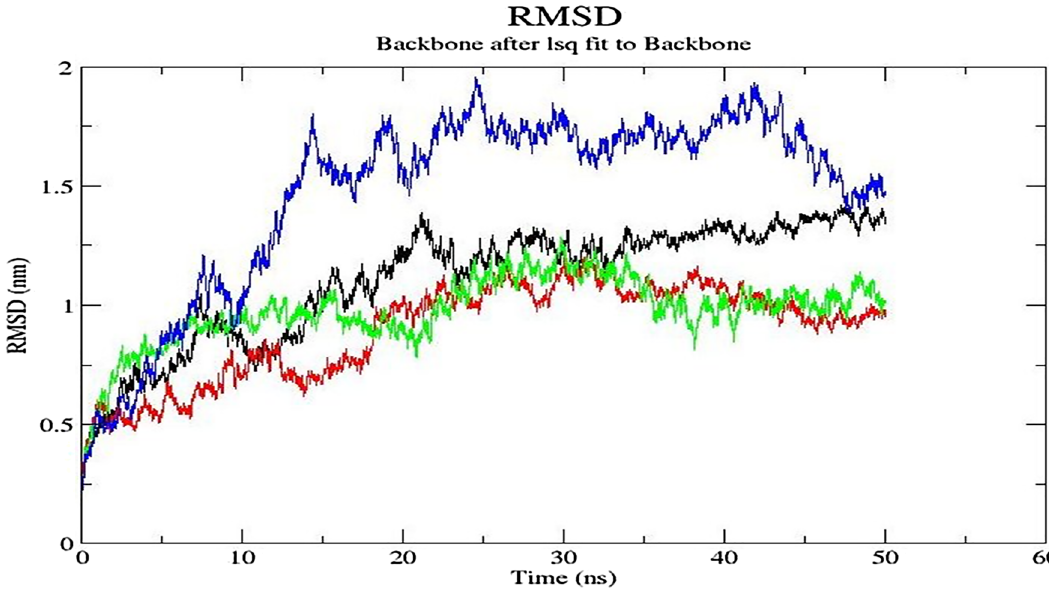
Figure 4. RMSD of the backbone atoms of the final structure relative to energy minimized structure vs. time plot for 50 ns simulation, for unphosphorylated and phosphorylated I-TASSER-generated STAT3-GRIM-19 complex (in black and red lines, respectively); and for unphosphorylated and phosphorylated AlphaFold2- generated STAT3-GRIM-19 complex (in green and blue lines,